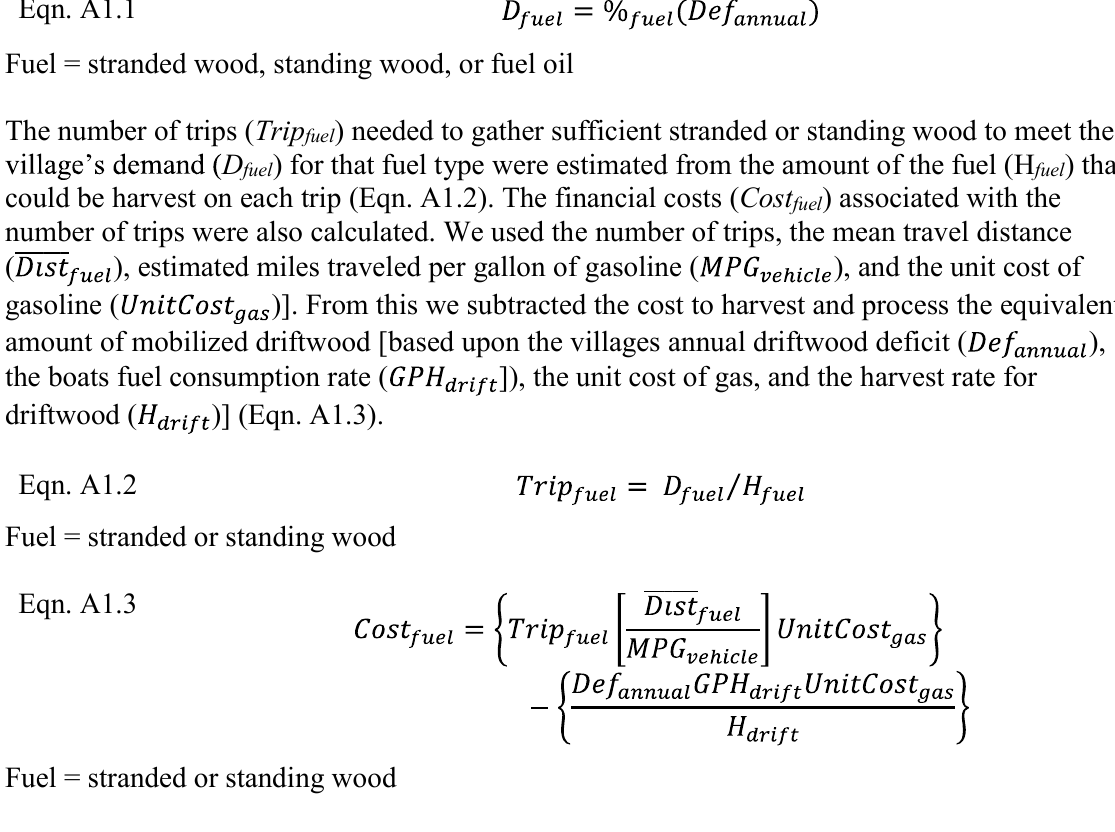
Table A1.1 defines the parameters used to estimate costs and identifies the source for the parameterization. The fuel equivalent ( D fuel ) of each substitute fuel type used to meet any wood deficit ( Def annual ) was estimated based on specified proportions of each potential fuel type used as a driftwood substitute ( % fuel ) in the entire village (Eqn. A1.1). The potential substitute